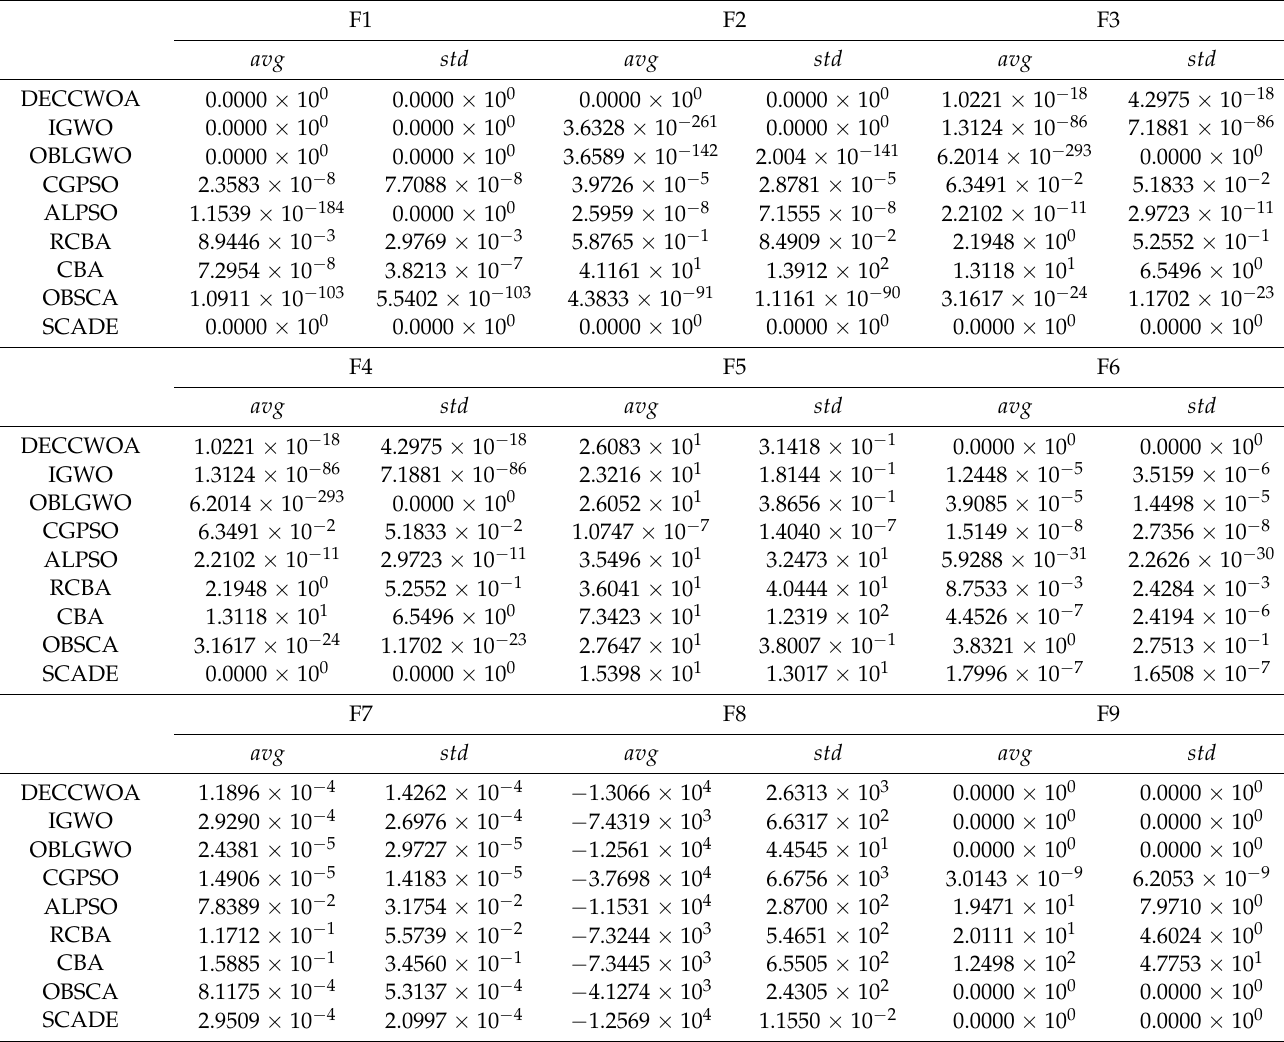
Table A5. Comparison results for the DECCWOA with advanced